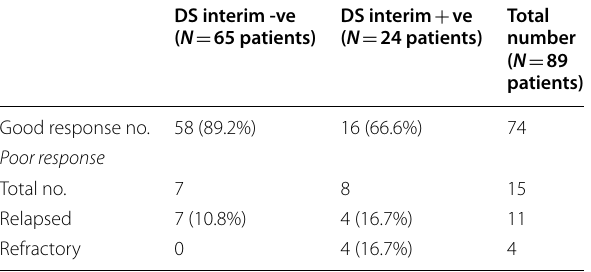
Table 5 DS early response assessment and prognosis in extra‑ nodal lymphoma